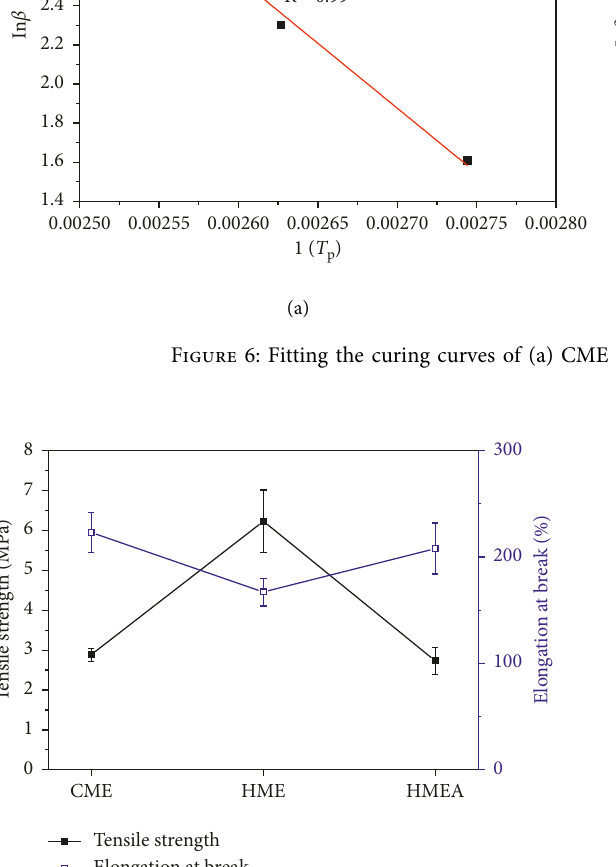
Tensile strength Elongation at break Figure 7: Tensile properties of the CME, HME, and